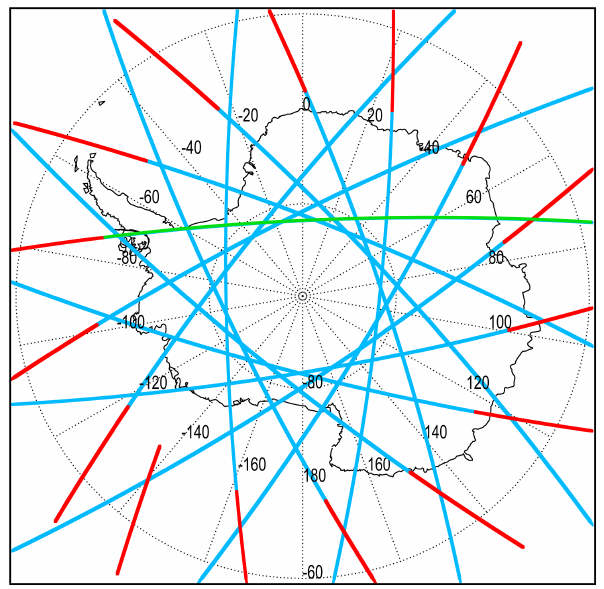
Figure 1. CALIPSO orbital coverage over the polar region of the Southern Hemisphere on 17 July 2008. Blue (red) lines depict night- time (daytime) orbit segments. The CALIOP curtain along the orbit highlighted in green is shown in Fig.